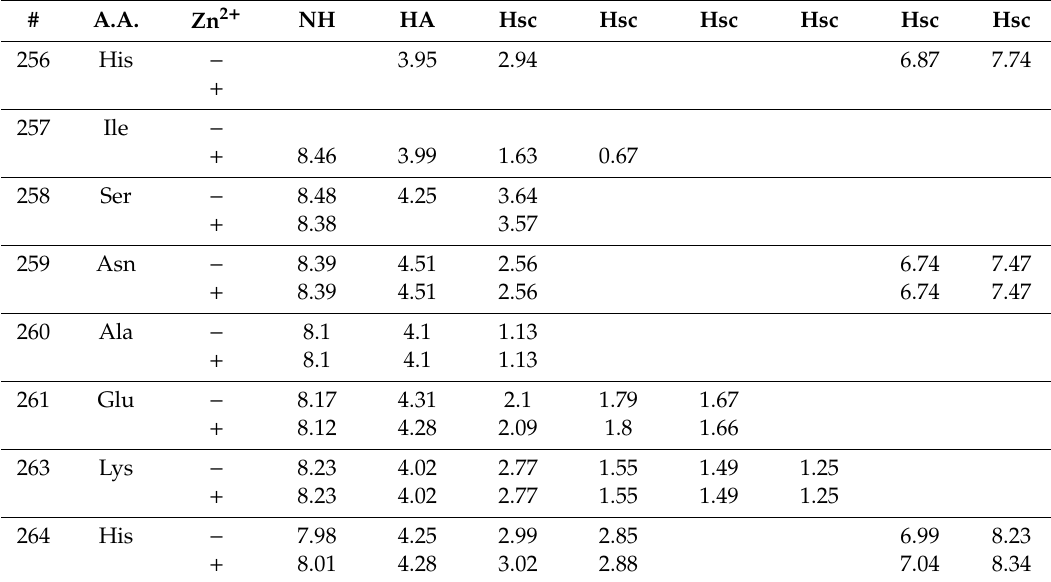
Table 1. Proton chemical shifts of ALR peptide at 290 K and pH 6.8. NH indicates proton in NH groups, HA, the protons on the CA and Hsc, protons on the side